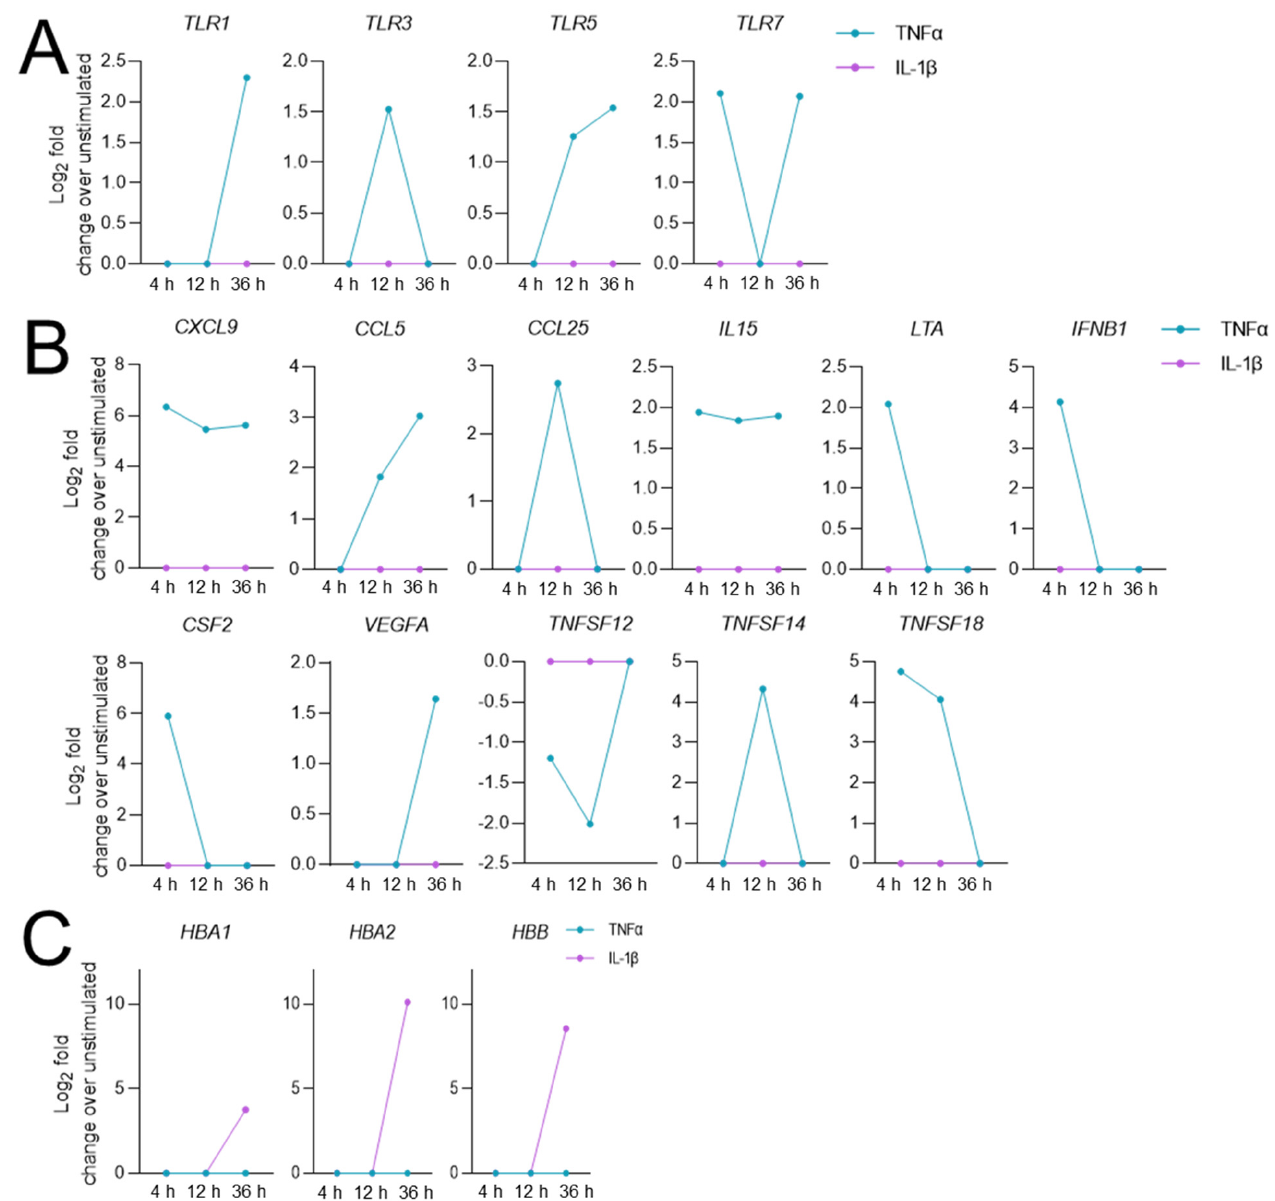
Figure 5. Gene expression profiles of ( A ) Toll-like receptor (TLR) subtypes, ( B ) Chemokines, cytokines and interleukins, and ( C ) Hemoglobins that are uniquely differentially expressed in human cortical spheroids following stimulation with either TNF α or IL-1 β for 4 h, 12 h and 36 h.